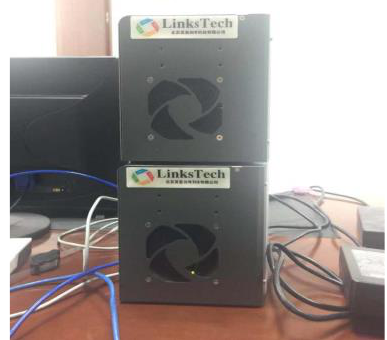
Figure 4. Overall diagram of longitudinal HFV model adaptive sliding mode NDI control.